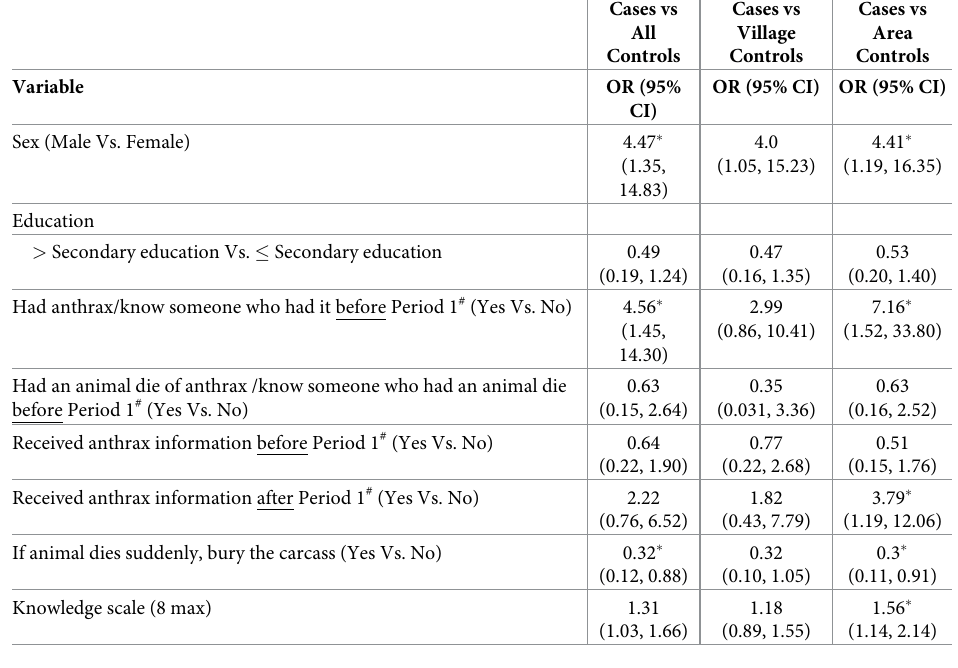
Table 3. Bivariate analyses of anthrax knowledge, attitudes, and practices among livestock handlers in